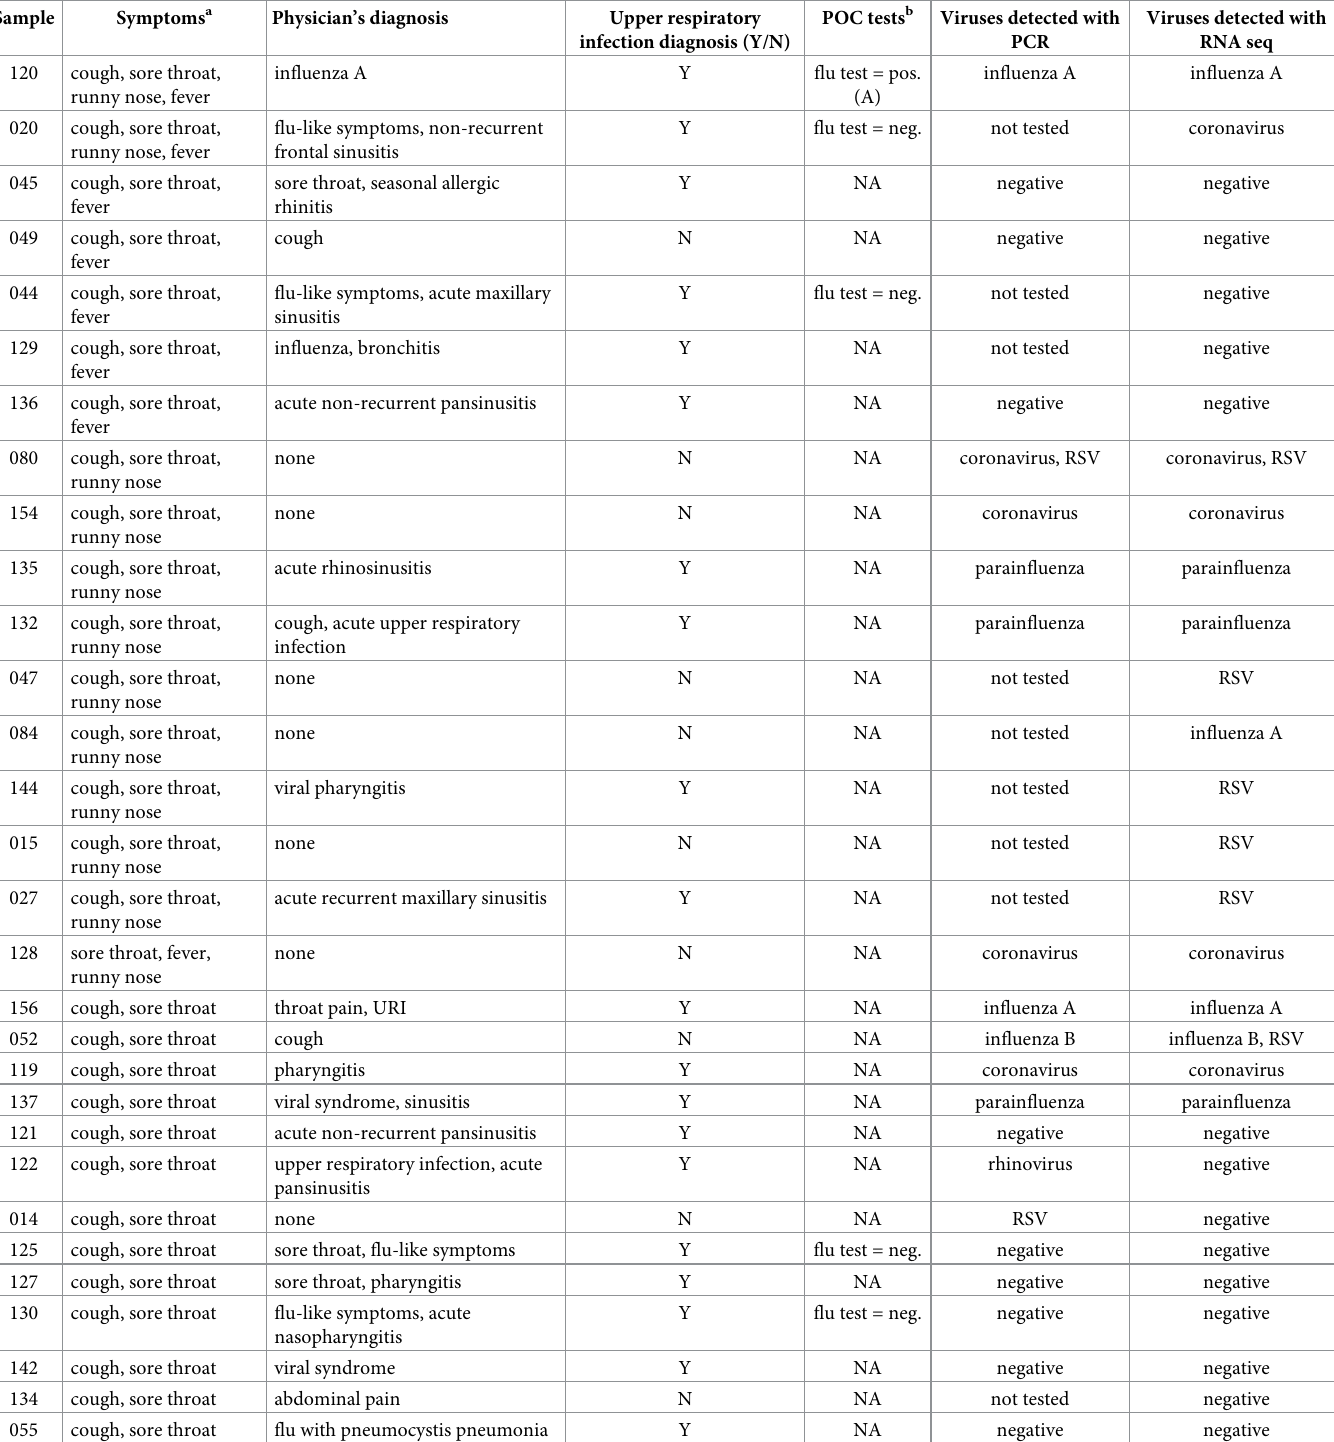
Table 3. PCR results, shotgun RNA sequencing results, and physician’s diagnosis in individuals with symptoms of respiratory infection (n = 52). Individuals not included here (n = 45) had symptoms of respiratory infection, but did not have a physician’s diagnosis or a POC test, and were negative by both PCR and/or sequencing. Two individuals did not have symptoms, or a diagnosis, of upper respiratory infection, but were positive for a virus. Five additional individuals were given a diagnosis of upper respiratory tract infection even though they did not present with upper respiratory infection symptoms focused on